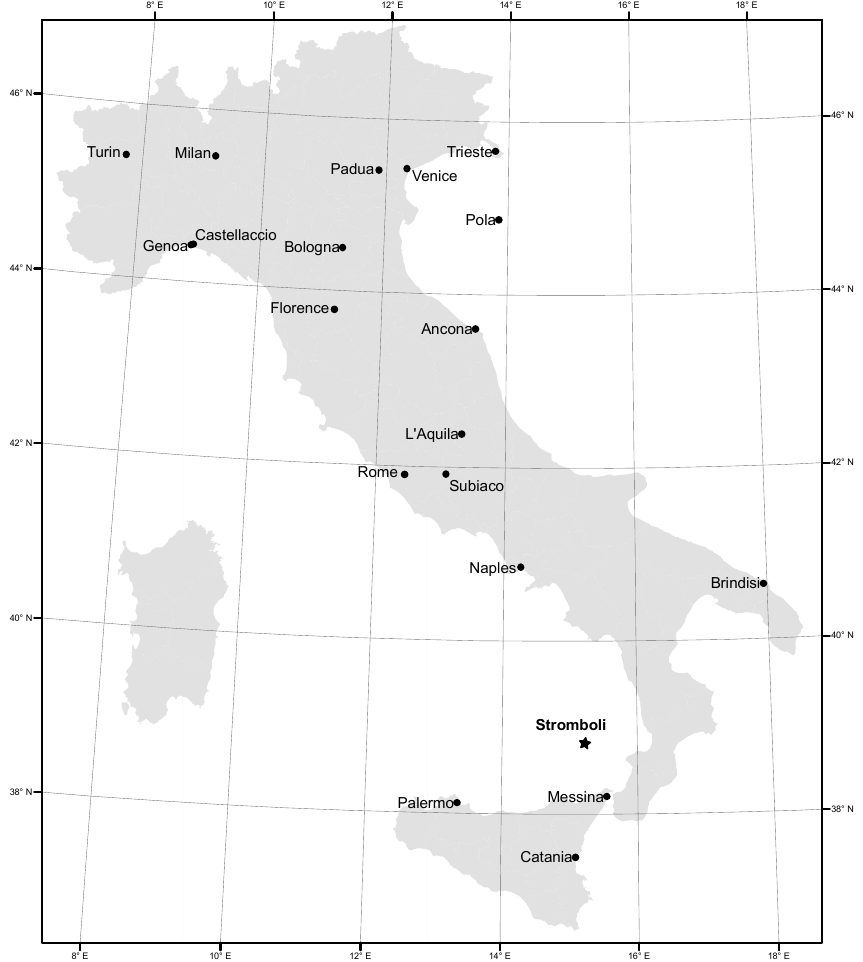
Fig. 1. The 19 localities of Italy where declination/inclination time series were gathered since 1640 (Cafarella et al., 1992; data are listed in Database S1, see Supplement). Stromboli is the site to which all geomagnetic directions were